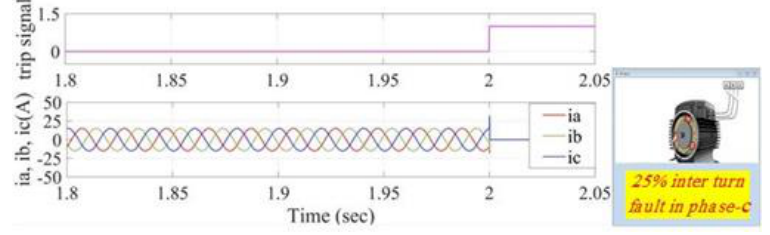
Figure 20. Stator current and trip signals for 25% inter-turn fault in phase-b and 10% inter-turn fault in phase-a (application of the proposed method when it uses its non-overlapping window frame algorithm).